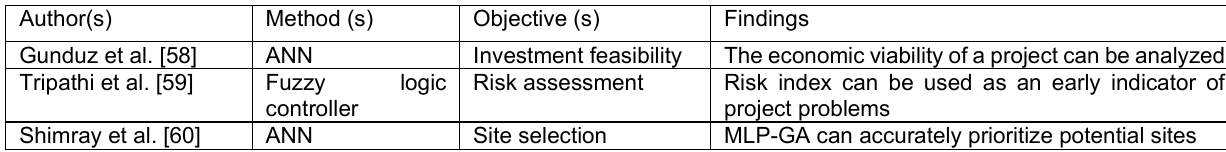
v) Applications of AI for feasibility study: